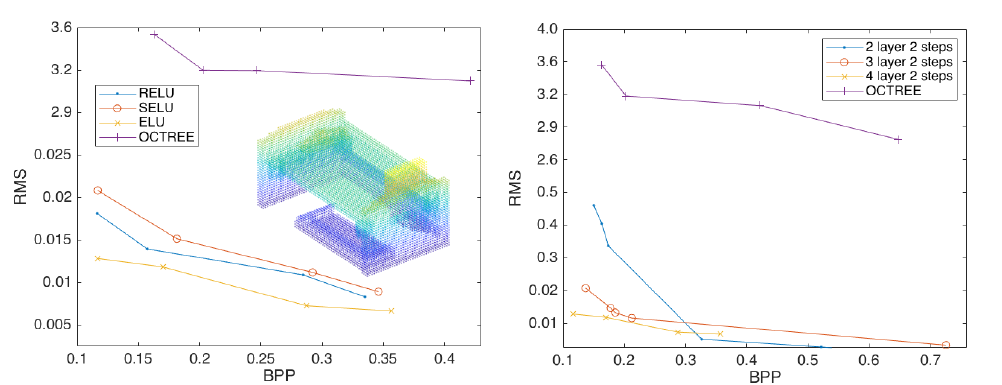
Figure 5. The compression performance of the scheme configured with four layers of convolution, and two strides, using the activation functions Relu , Selu , and Elu ( left ). Comparison of convolution effects of each layer ( right ).